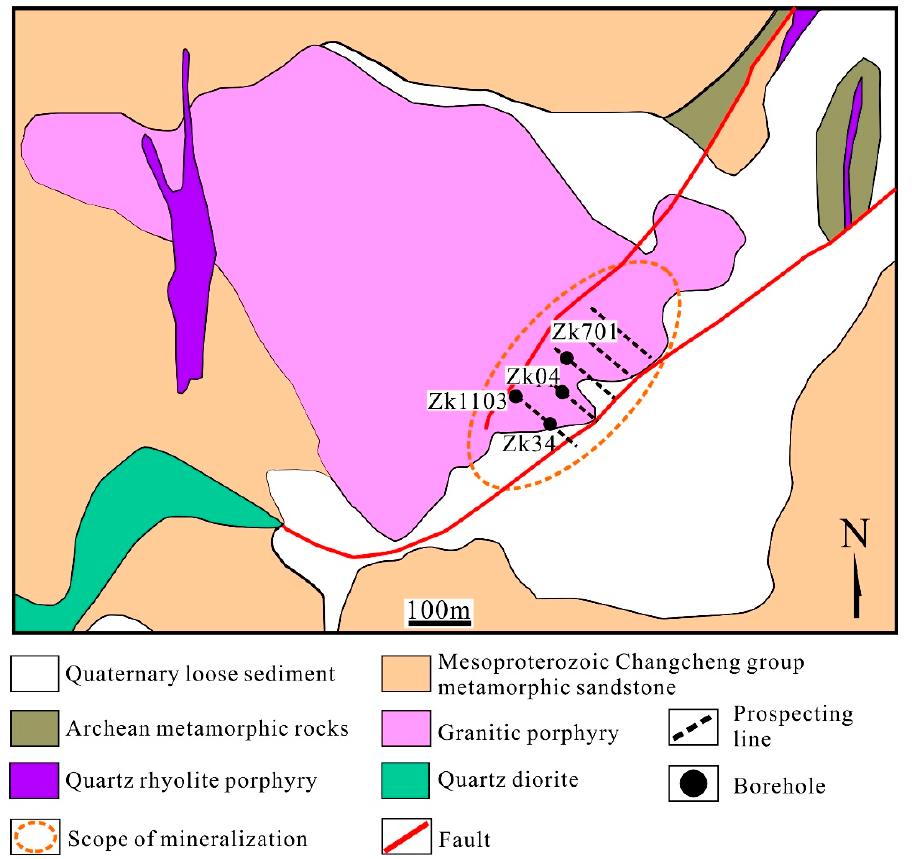
Figure 2. Geological maps of the Xiajinbao gold deposit.